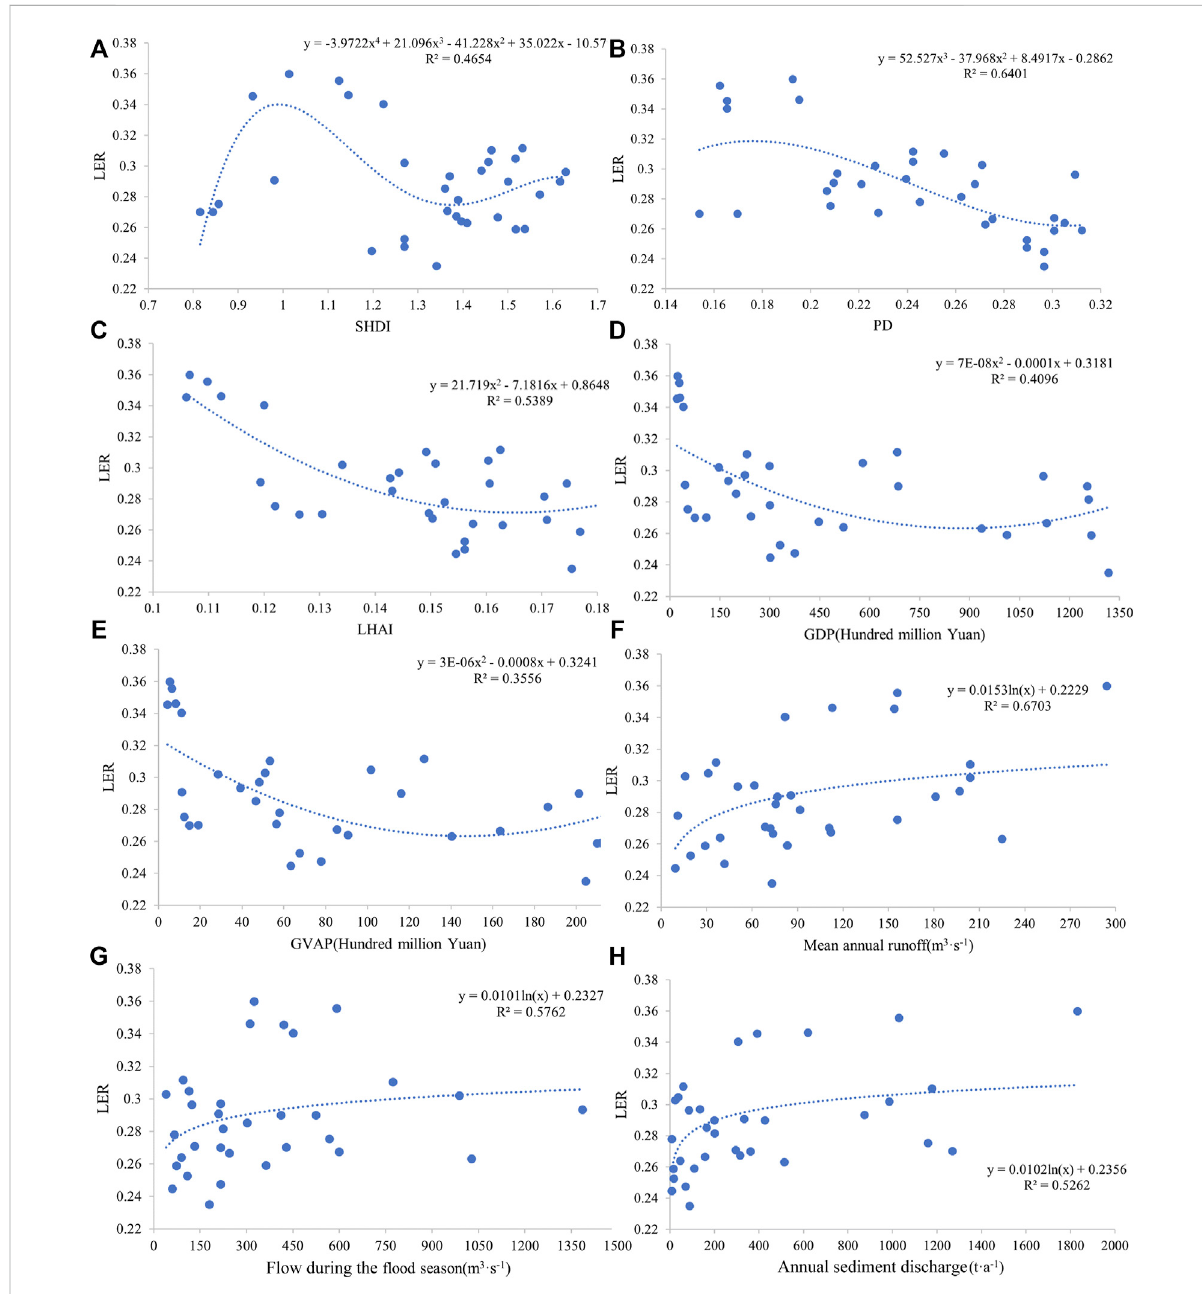
FIGURE 6 DifferentkindsofdrivingforcesonEcologicalriskinthetidal fl at:thelabels (A – H) representSHDI,PD,LHAI,GDP,GVAP,meanannual fl ow, fl ow during the fl ood season, and annual sediment discharge